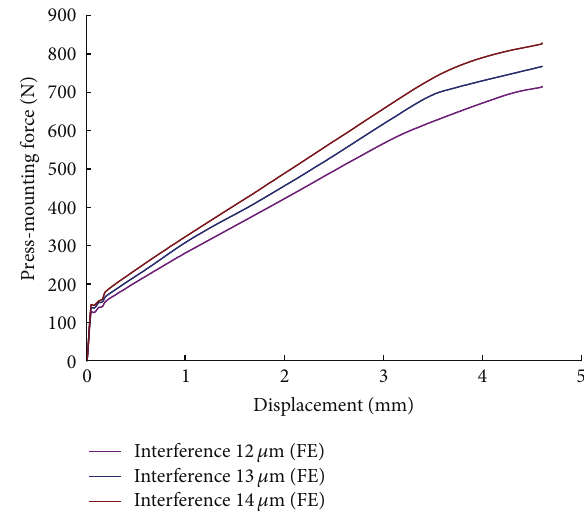
Figure 5: Press-fit curves obtained from FEA.